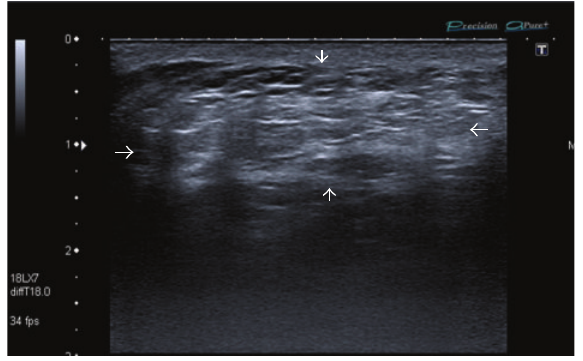
Figure 2: Ultrasound examination (longitudinal view) demon- strates a large subcutaneous mass (bounded by white arrows) in the interscapular region with sonographic features consistent with a lipoid mass, that is, elliptical shape, heterogeneity, longest axis par- allel to the skin surface, lack of posterior acoustic enhancement or attenuation, and presence of multiple echogenic lines perpendicular to the ultrasound